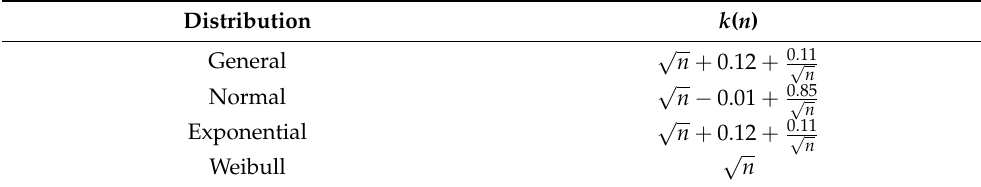
Table 2. k ( n ) according to the distribution